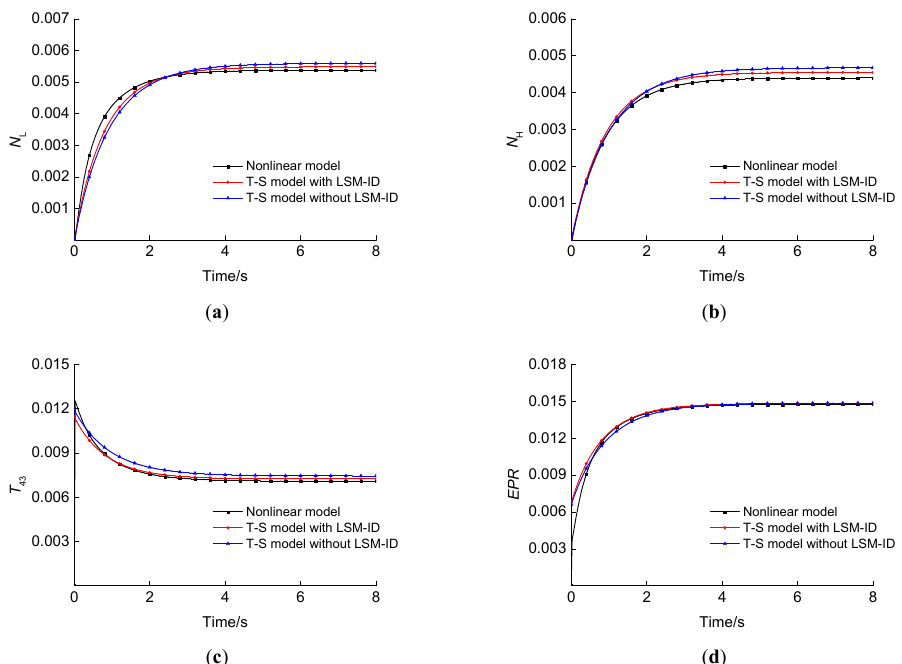
Figure 10. Responses under 10.5 km and 1.22 Mach. ( a ) N L response comparison. ( b ) N H responses. ( c ) T 43 responses. ( d ) EPR responses.